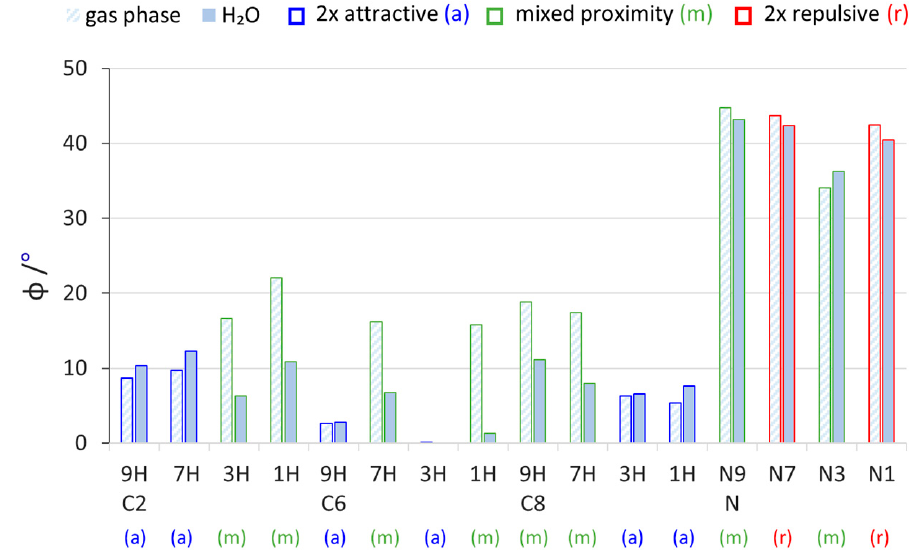
Figure 2. Values of pyramidalization of the NH 2 group ( φ = 360° − sum of valence angles at the N atom) in all studied aminopurines calculated in the gas phase and water (H 2 O).